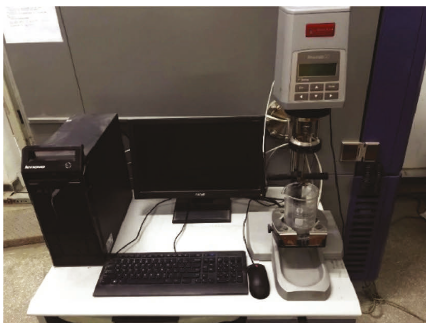
Figure 4: Rheometer.